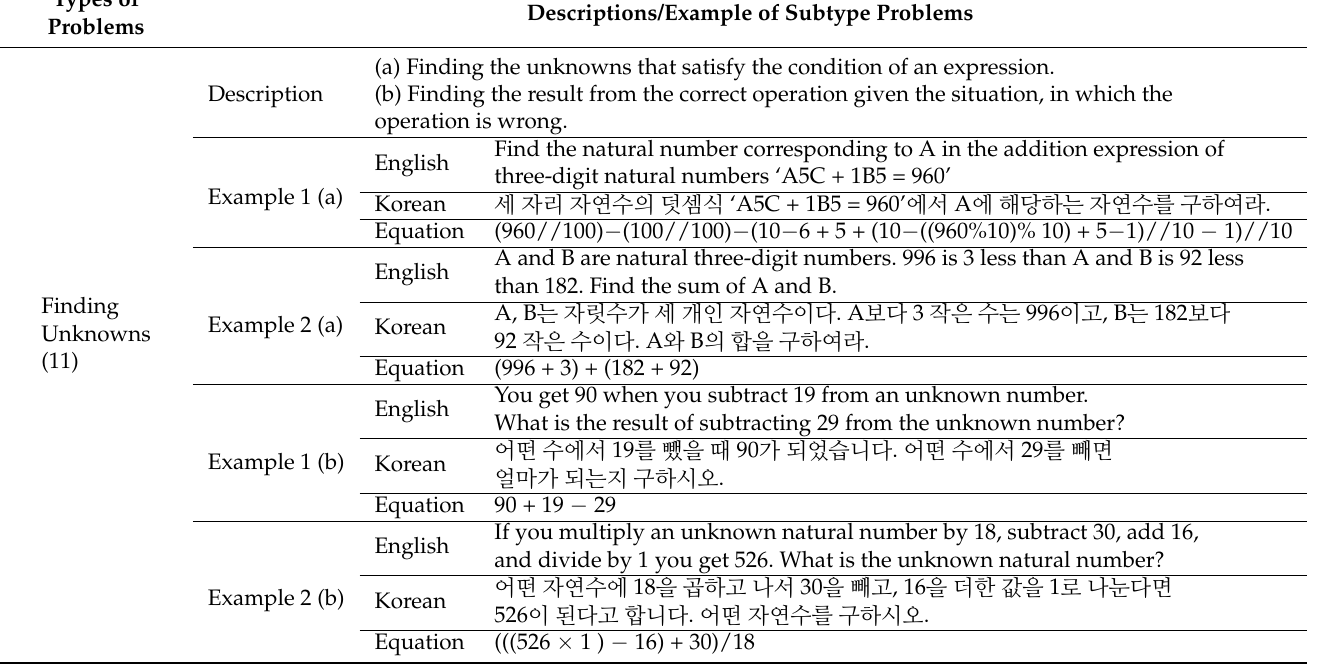
Table 3. Examples of the finding unknowns